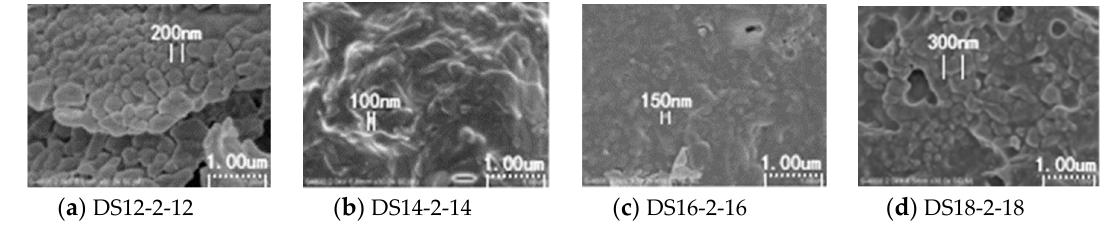
Figure 1. Effect of hydrophobic chain on the viscosity of DSm-2-m solution.